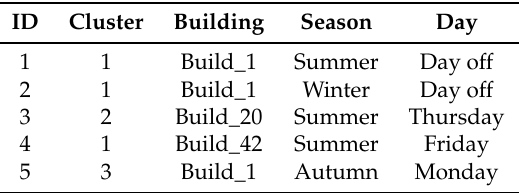
Table 2. Example of a dataset along with assigned cluster and